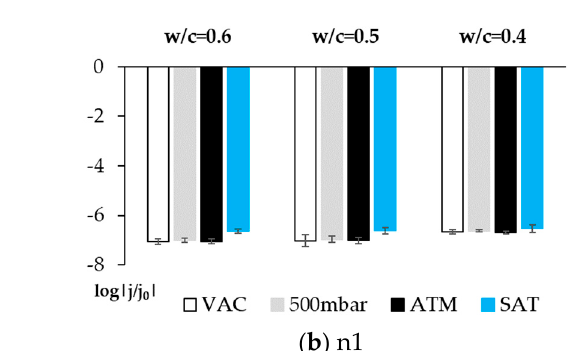
Figure 10. The cyclic voltammetry results obtained with the SS sensor in hardened concrete under atmospheric (ATM) and H 2 O-saturation (SAT) conditions using the 2-electrode technique. Ohm drop is corrected. ( a ) Voltagram of concrete w/c = 0.6. ( b ) Voltagram of cathodic sweeping represented logarithmically and corresponding to Figure ( a ), concrete w/c = 0.6. ( c ) Voltagram of concrete w/c = 0.5. ( d ) Voltagram of cathodic sweeping represented logarithmically and correspond- ing to Figure ( c ), concrete w/c = 0.5. ( e ) Voltagram of concrete w/c = 0.4. ( f ) Voltagram of cathodic sweeping represented logarithmically and corresponding to Figure ( e ), concrete w/c = 0.4.